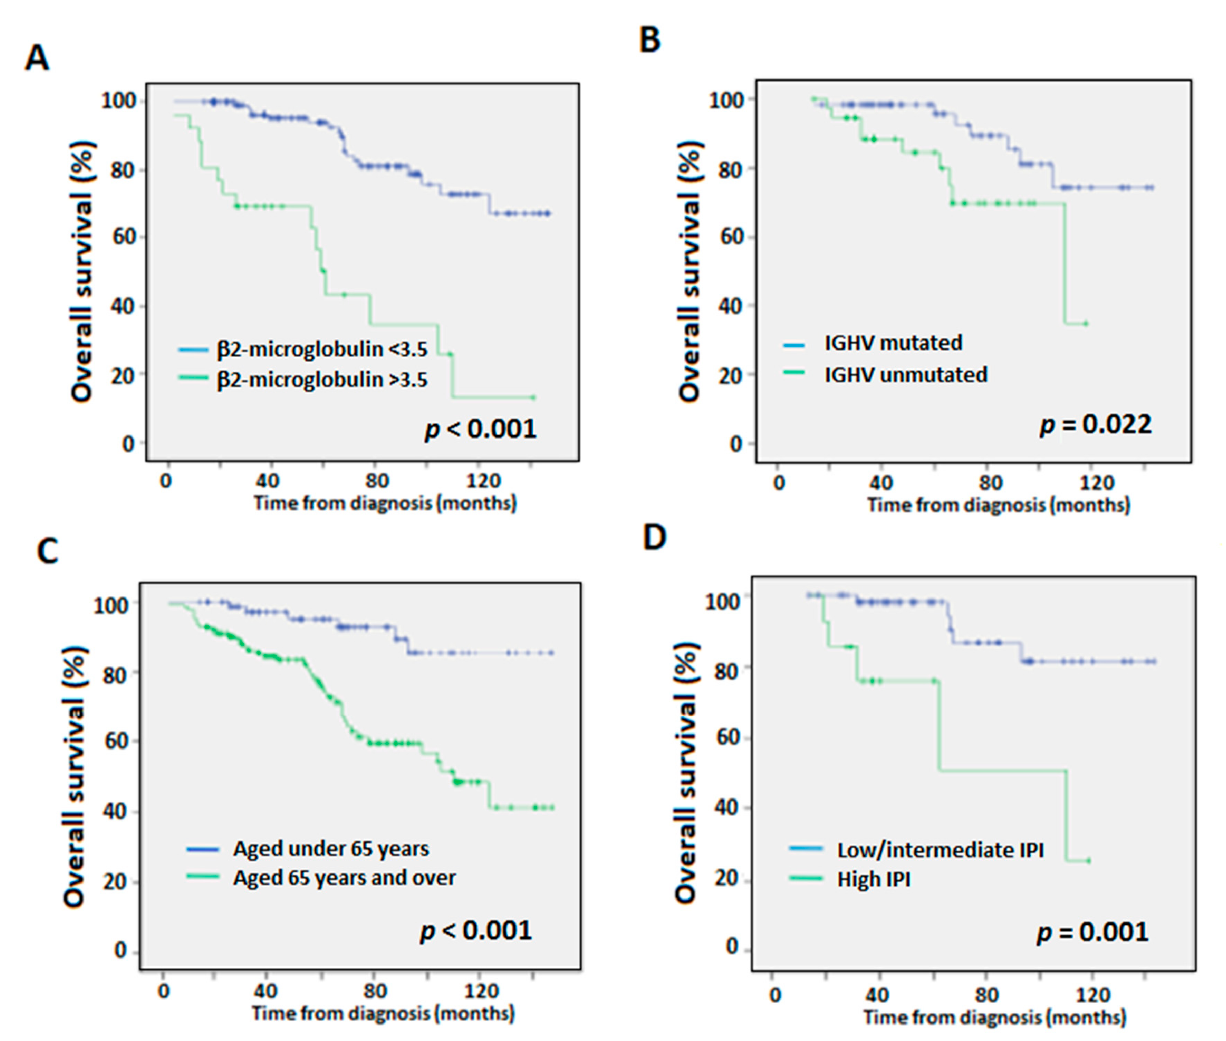
Figure 2. Overall survival (OS) Kaplan-Meier curves according to ( A ) β 2 -microglobulin levels, ( B ) IGHV mutational status, ( C ) age, and ( D ) low/intermediate- vs. high-risk CLL-IPI categories. p -values according to Log-Rank test.